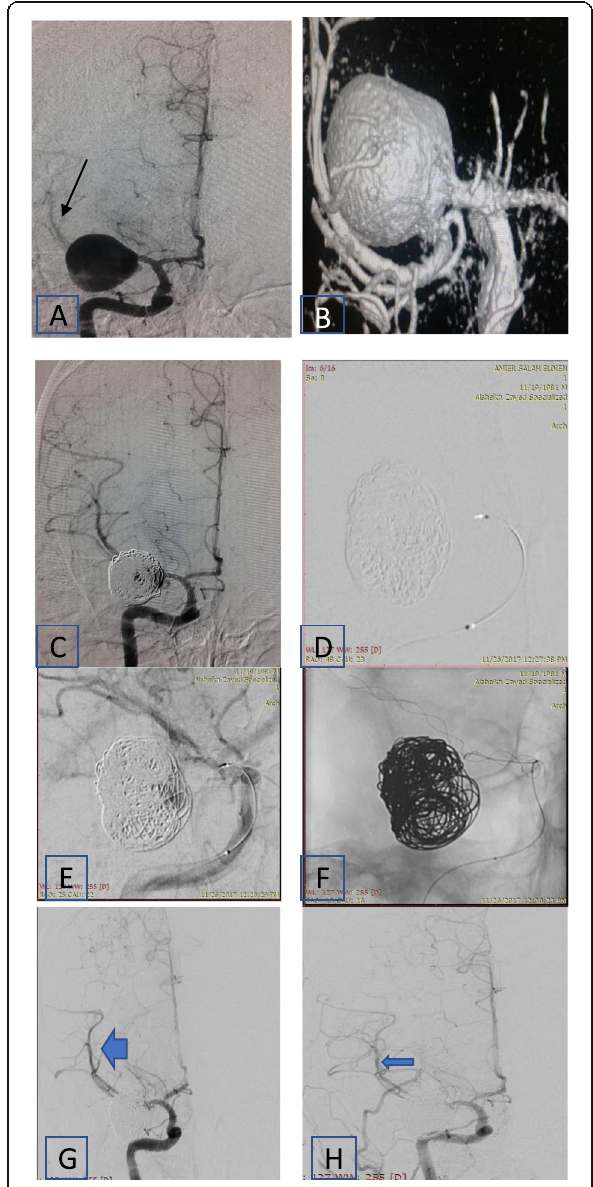
Fig. 5 Stent-assisted coiling of large M1-M2 aneurysm that requires further treatment after first follow-up; note the distal MCA branches filling after treatment. A A-P view showing large MCA, M1-M2 aneurysm; note the poor filling of the distal MCA branches (the black arrow). B 3D reconstruction image of the aneurysm. C After stent deployment, first follow-up showing contrast filling near the aneurysmal neck; subtraction image during advancement of the micro-catheter. E , F During microvascular passage through the mesh Struss. G , H Follow-up showing complete aneurysmal occlusion with noted good filling of the distal MCA branches (the blue